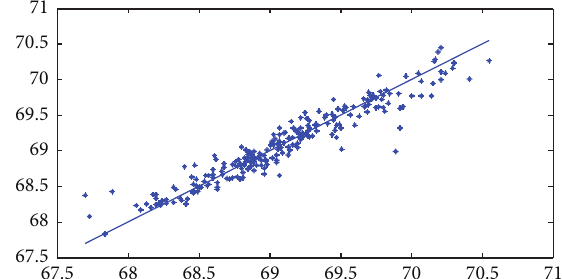
Figure 15: Scatter plots of observed and predicted groundwater levels using an ANFIS model (Pp 930).